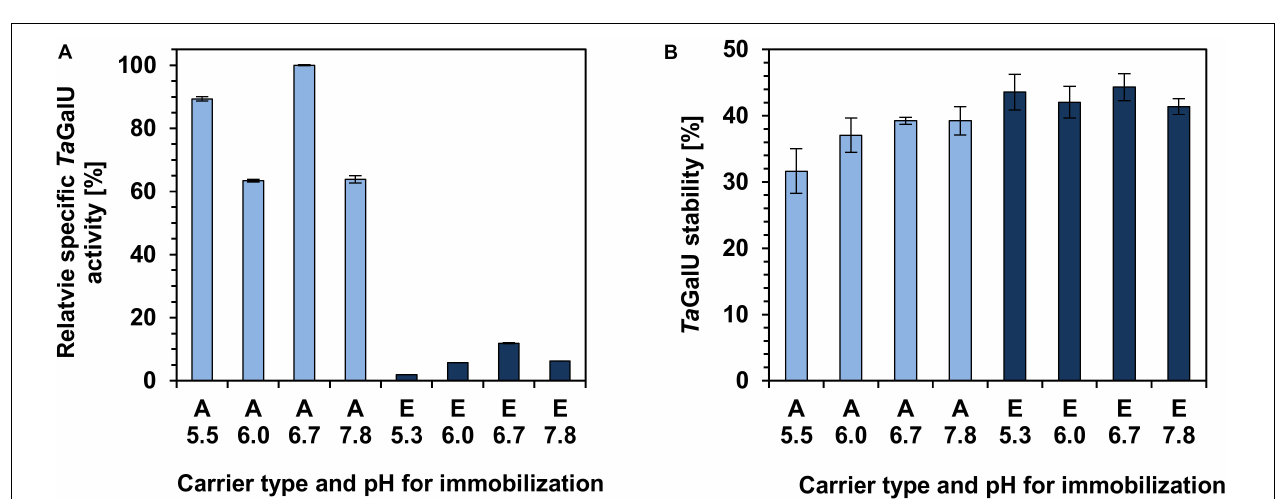
FIGURE 3 | The effect of functional groups of carriers (A, amino; E, epoxy) and immobilization pH on the specific activity (A) and storage stability (B) of Ta GalU. Reaction conditions: 18 µ g mL - 1 Ta GalU immobilized on MCF, 2 mM UTP, 2 mM G1P, 50 mM Hepes buffer, pH 7.0, 4 mM MgCl 2 , 30 ◦ C in 3 mL reaction volume and 5 min reaction time. Storage stability was measured with the same setup but after 1 month of storage at 4 ◦ C. (A) The highest activity of this experiment was set to 100%. (B) The initial activities were set to 100%. Means with standard deviations of duplicate measurements are